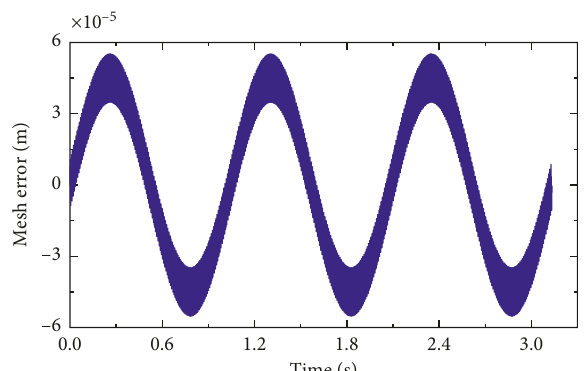
Figure 13: Mesh error of gear 3 and gear